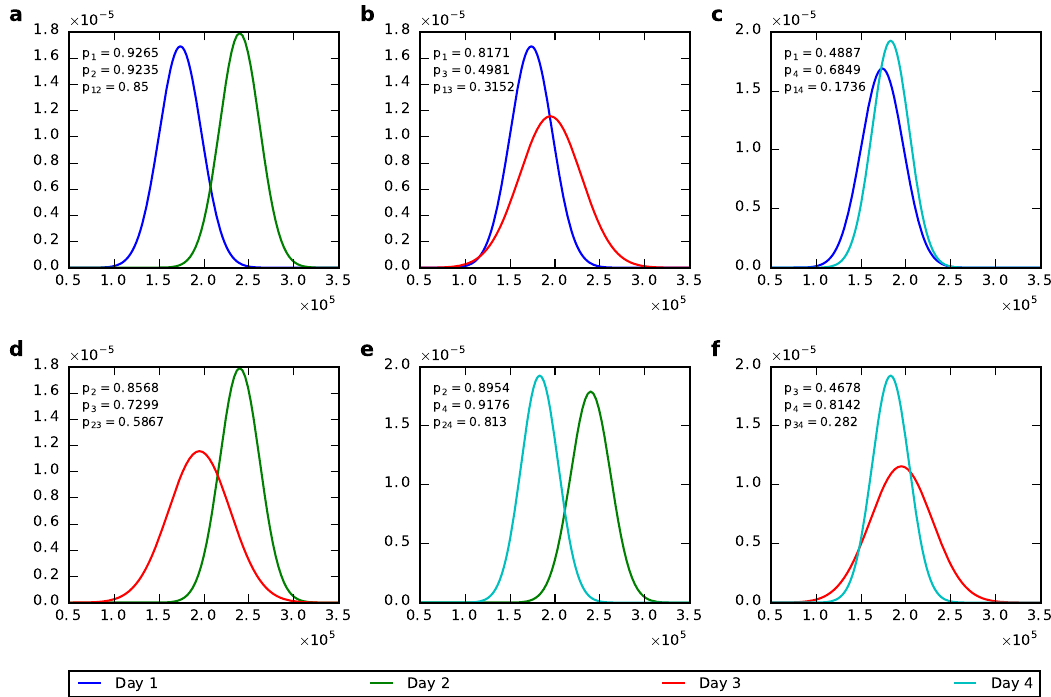
Figure 9. Probability density functions for each day (day 1, day 2, day 3, or day 4) of the measurement programme. Individual functions represent the coefficients that determine their association to a particular measurement day. The presented coefficients p 1 , p 2 , p 3 , and p 4 are the likelihood of qualifying the data for a particular day, whereas p 12 , p 13 , . . . , p 34 are the likelihood with which the data can be distinguished from another for each pair of days considered. The functions are compared in pairs: